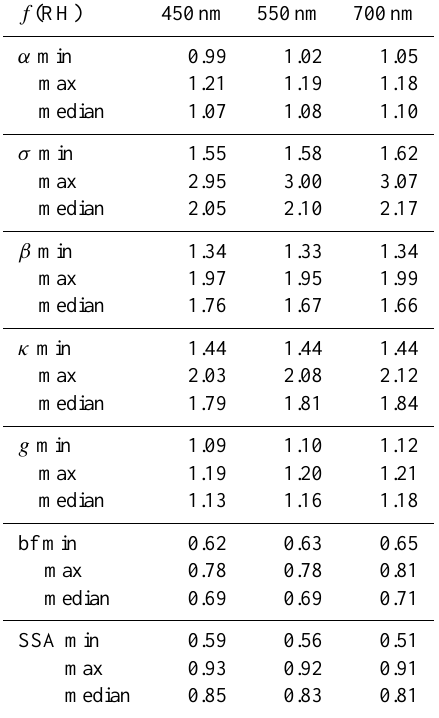
Table 2. Enhancement factor for optical variables (absorption – α , scattering – σ , backscattering – β , extinction – κ , asymmetry pa- rameter – g and backscatter fraction – bf). Also shown, single scat- tering albedo